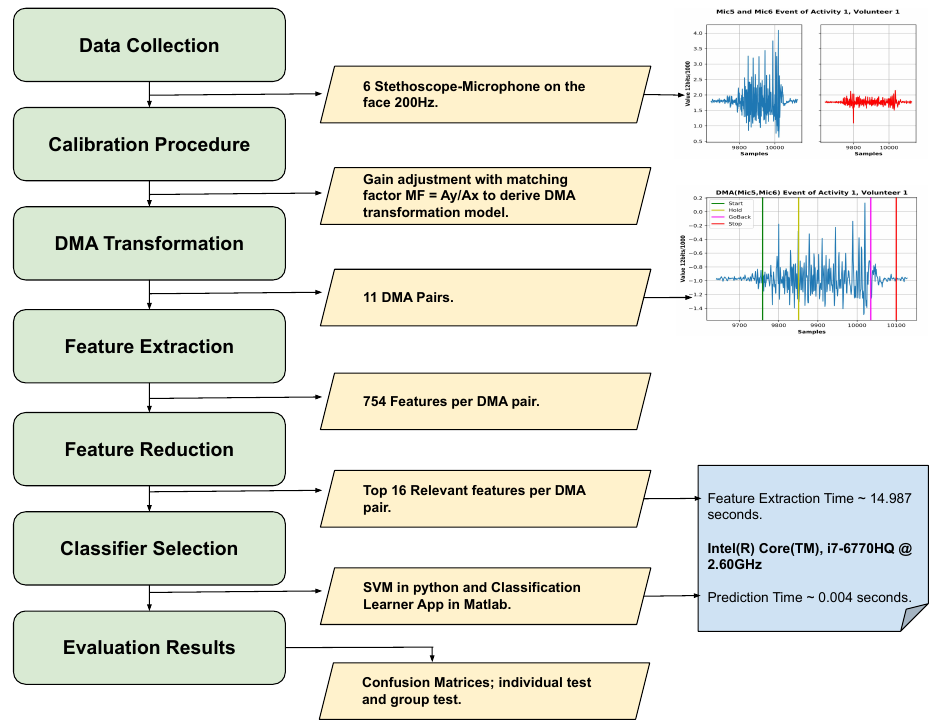
Figure 11. Flow diagram of the entire process done in this